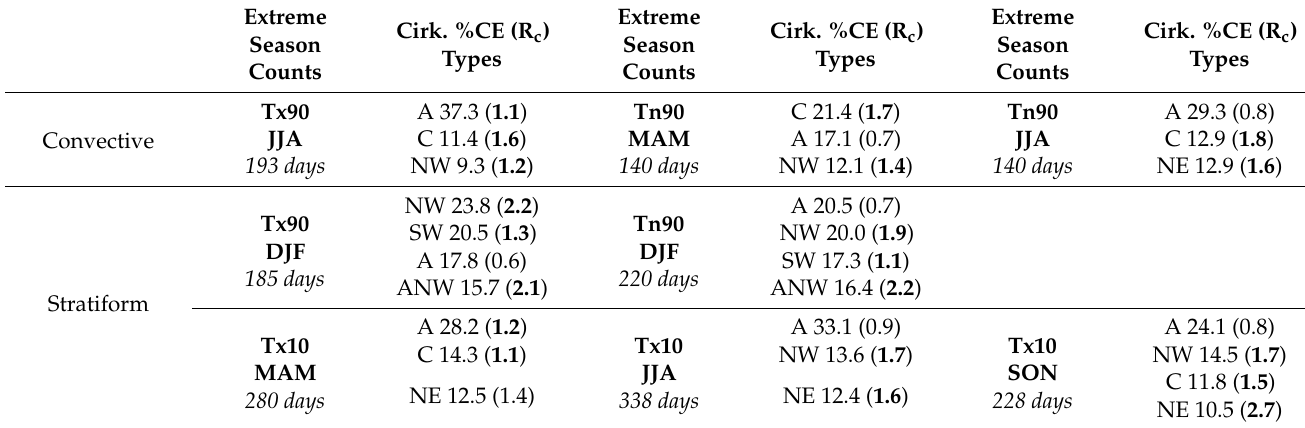
Table 5. Most frequent circulation types for given compound events. Percentage of days with the compound event and circulation type from all days with the compound event in a season (%CE). Table 1. 0 are highlighted). Numbers of days with given compound events from all stations are in